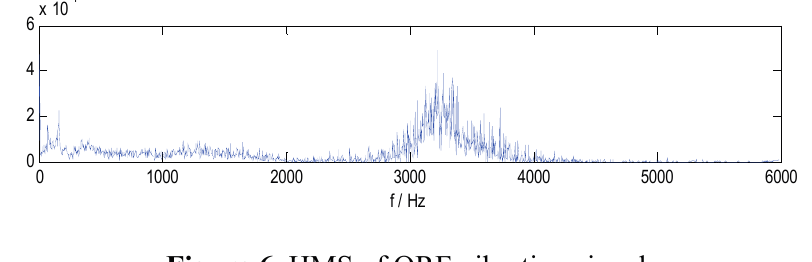
Figure 6. HMS of ORF vibration signal. Table 3. Statistical characteristic parameters of time domain and frequency